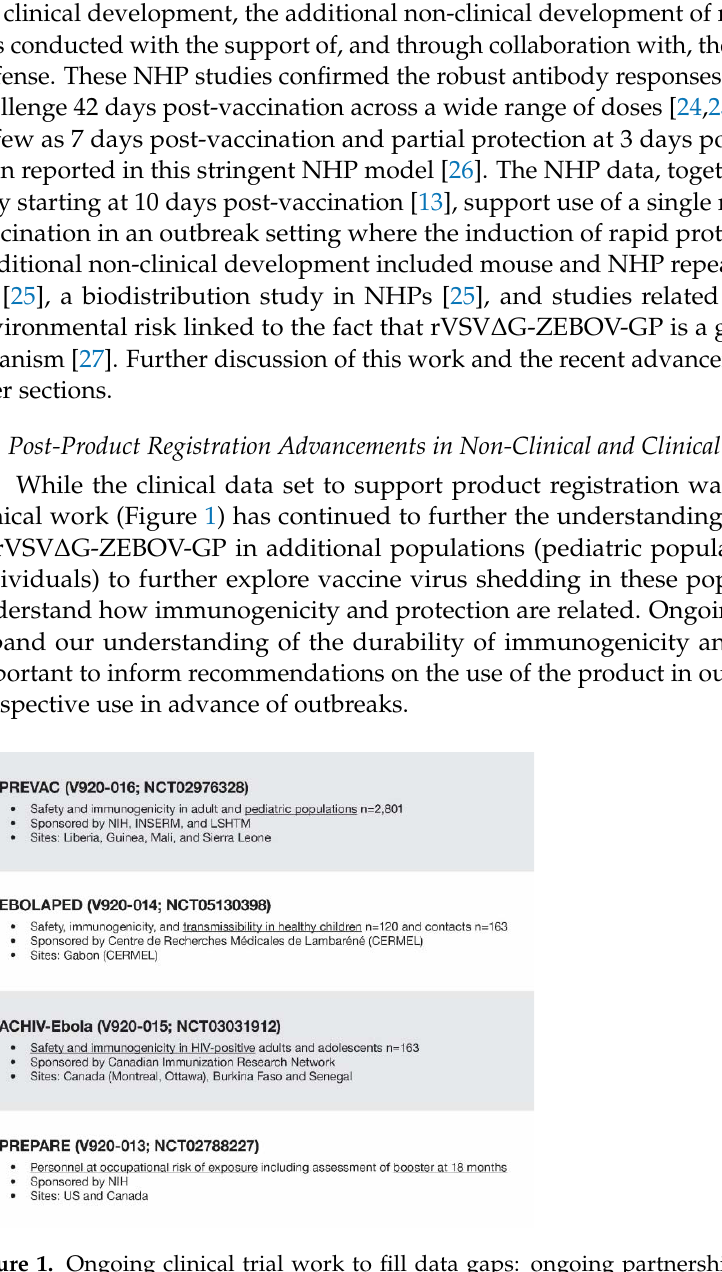
Figure 1. Ongoing clinical trial work to fill data gaps: ongoing partnerships. INSERM, Institut National de la Santé et de la Recherche Médicale; LSHTM, London School of Hygiene & Tropical Medicine; NIH, National Institutes of Health; U.S., United States.